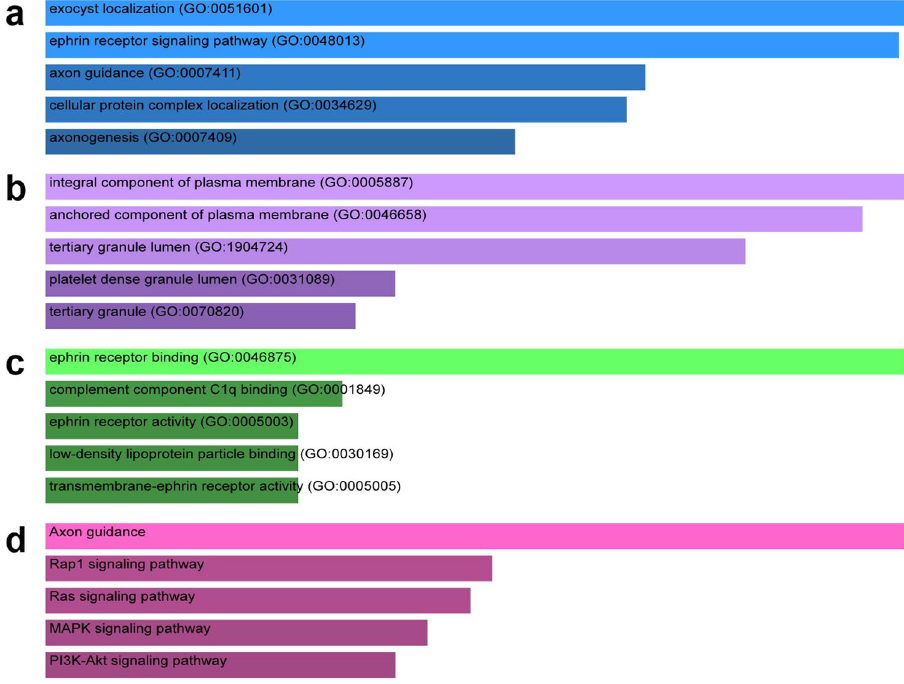
Figure 6. The enrichment analysis of TNFAIPs. ( a ) Bar plot of enriched GO BP terms. ( b ) Bar plot of enriched GO CC terms. ( c ) Bar plot of enriched GO MF terms. ( d ) Bar plot of enriched KEGG pathways 53